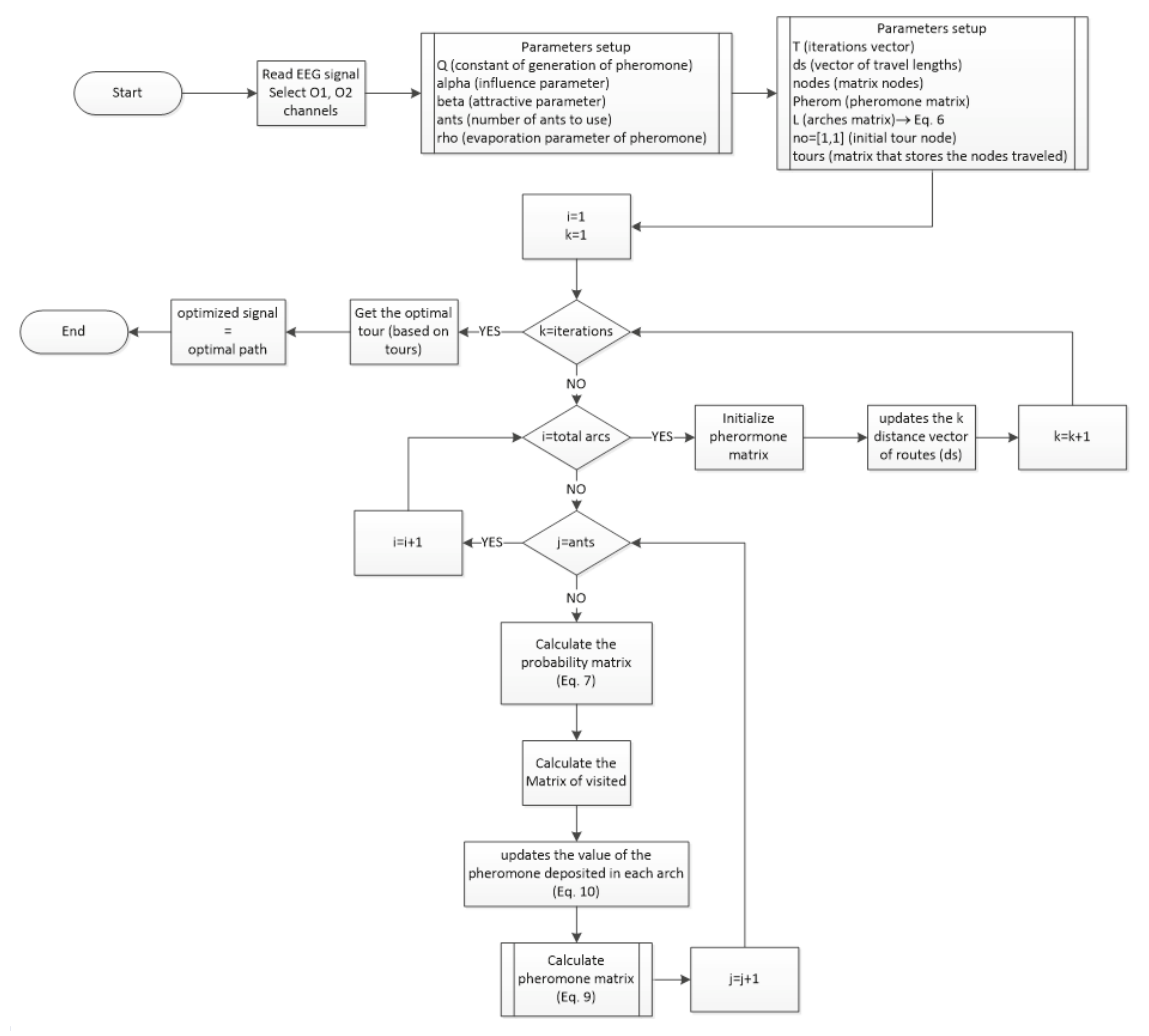
Figure 20: AS flowchart.